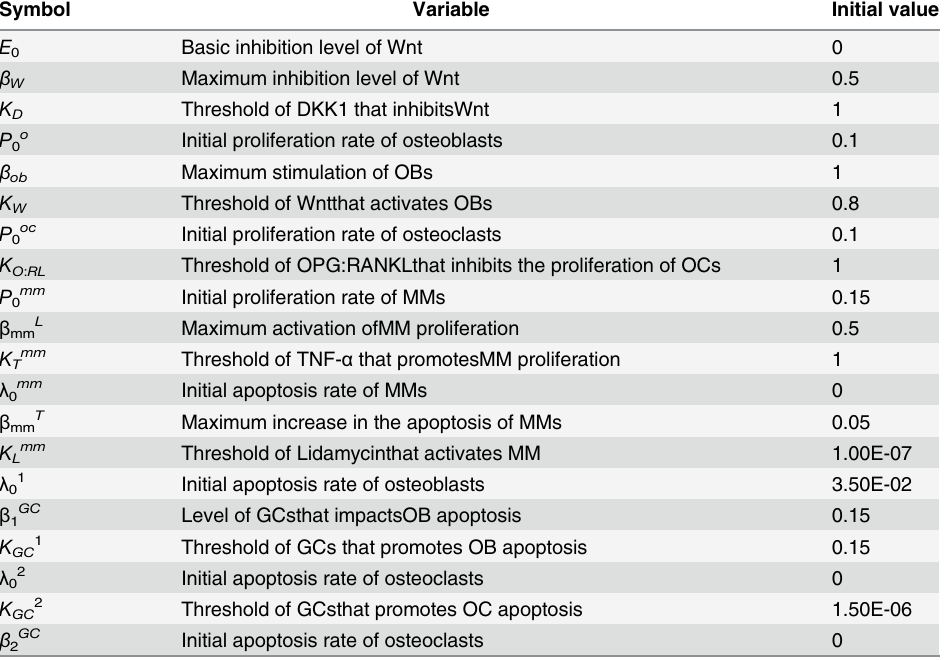
Fig 4 shows that the three curves began to separate at time step 20. The number of MMs (blue) intersected the number of OCs (green) around time step 90. After 120 time steps, the number of OCs and MMs increased three-fold and four-fold, respectively, compared to their initial values, whereas the number of OBs approached zero. Fig 5 shows the three-dimensional snapshots of the OBs, OCs and MMs at time points 0 and 120 without drug treatment. Table 1. System parameters.